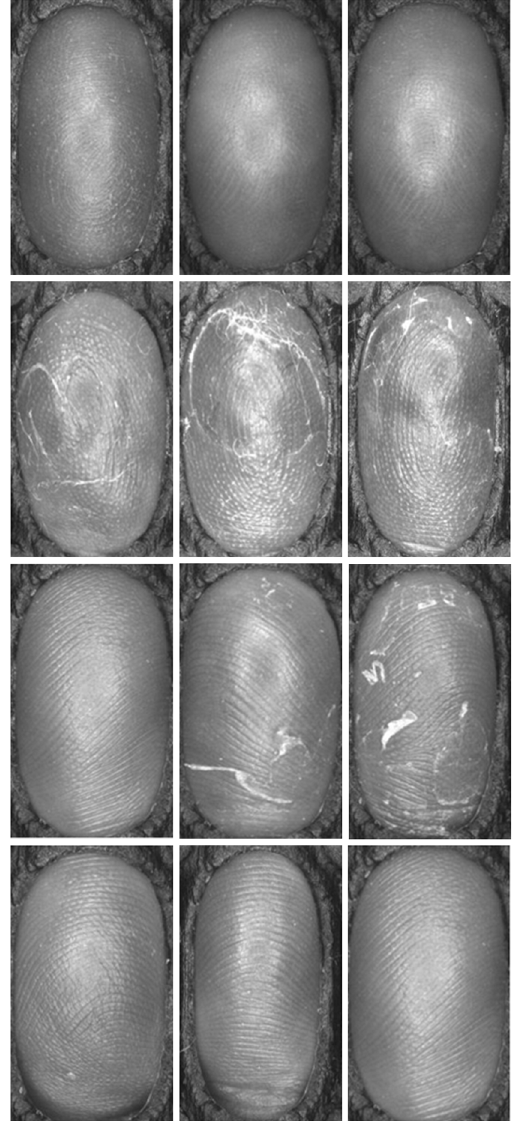
Figure 2. Newborn skin peeling issues: (Top to bottom) pre- peeling, peeling, partial peeling and post-peeling.